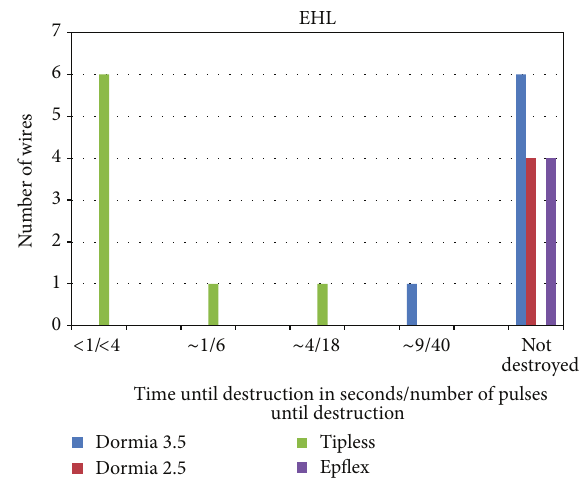
Figure3:TheEHLdestroyedalltiplessbasketswiresinarangefrom 1 to 4sec/fewer than 4 to 18 pulses. The one 3,5 Dormia basket was destroyed after 9 sec/40